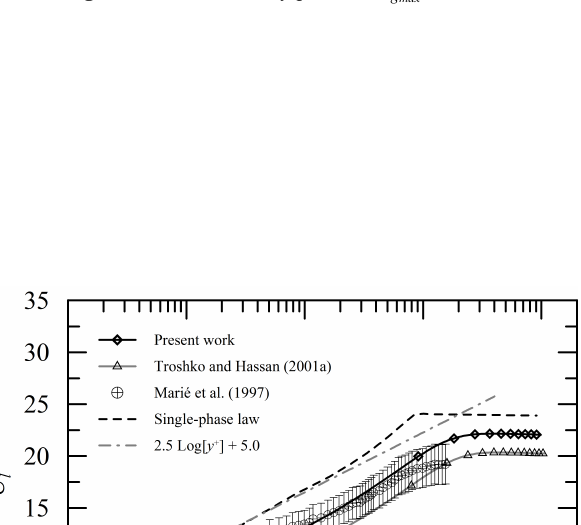
Figure 5 - Mean velocity profiles, α g